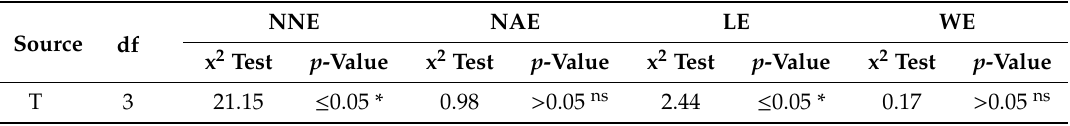
Table 2. Analysis of deviance for the e ff ect of di ff erent maturation temperatures in the number of normal (NNE) and aberrant somatic embryos (NAE) per 0.08 g of embryonal masses; the length (LE-mm) and width of normal embryos (WE-mm) of Pinus halepensis Mill.